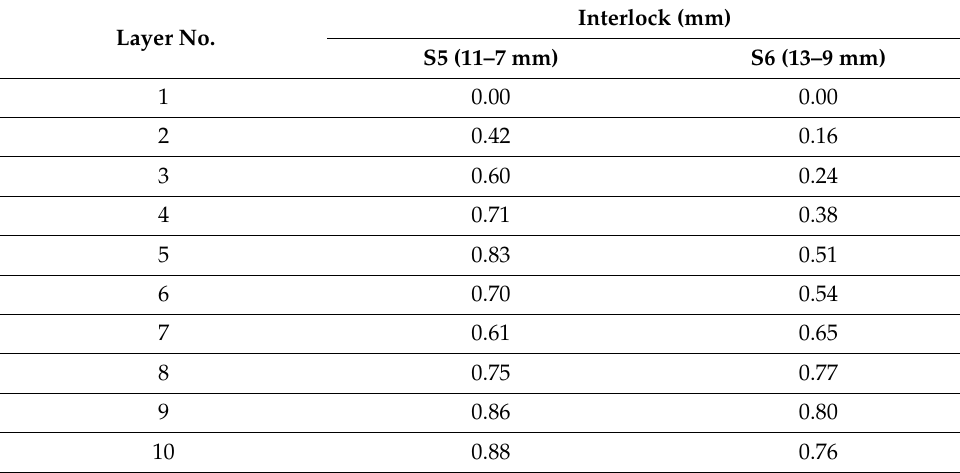
Figure 17. Cross section of plasticine clinch joint experiments: ( A ) S5 plasticine joint 11–7 mm; ( B ) S6 plasticine joint 13–9 mm. Table 4. Interlock of each layer in experiments S5 (11–7 mm) and S6 (13–9 mm) with glycerin lubricant. Layers are numbered from the bottom.